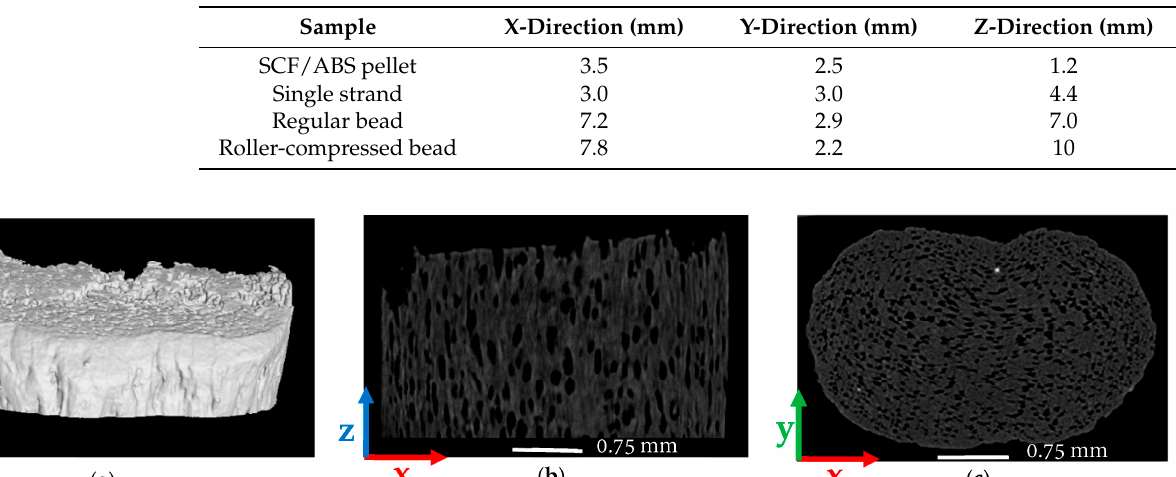
Table 3. Nominal dimensions of SCF/ABS.